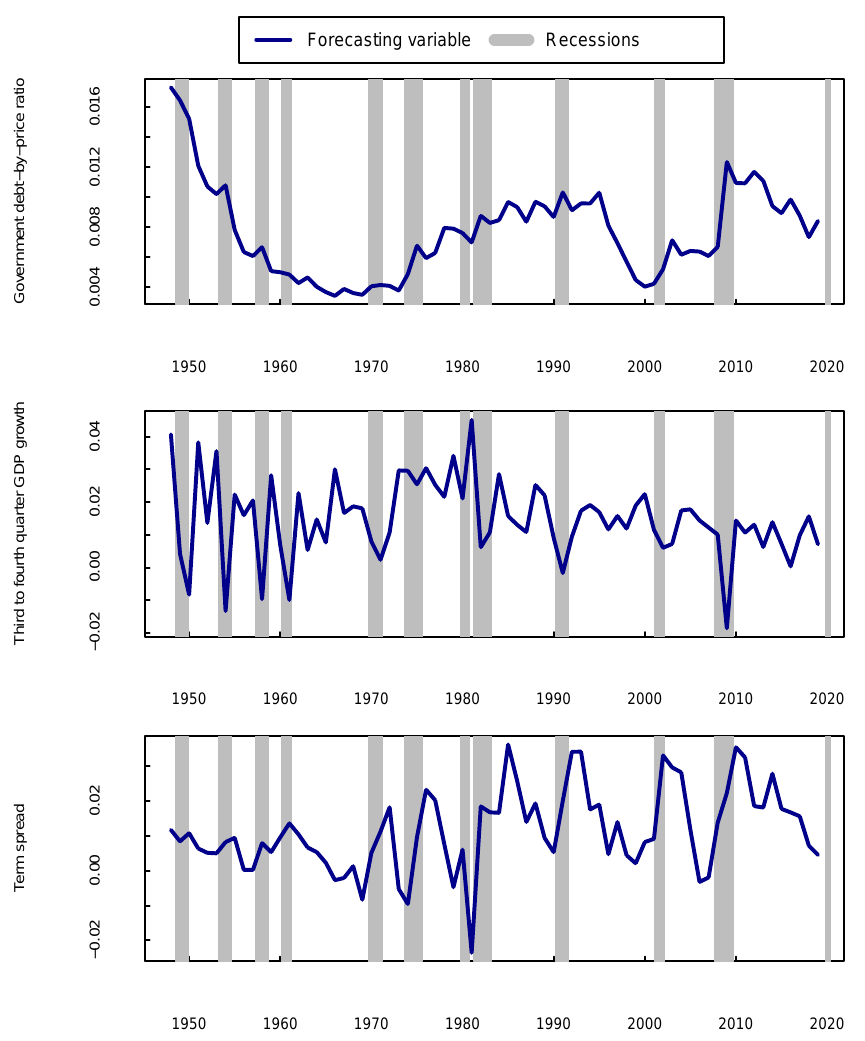
Figure 2. The most successful forecasting variables detected in this analysis (dark blue line). From top to bottom: debt-by-price ratio, third to fourth quarter GDP growth and term spread. Vertical lines (gray area) are the NBER business-cycles (recessions). The sample period is